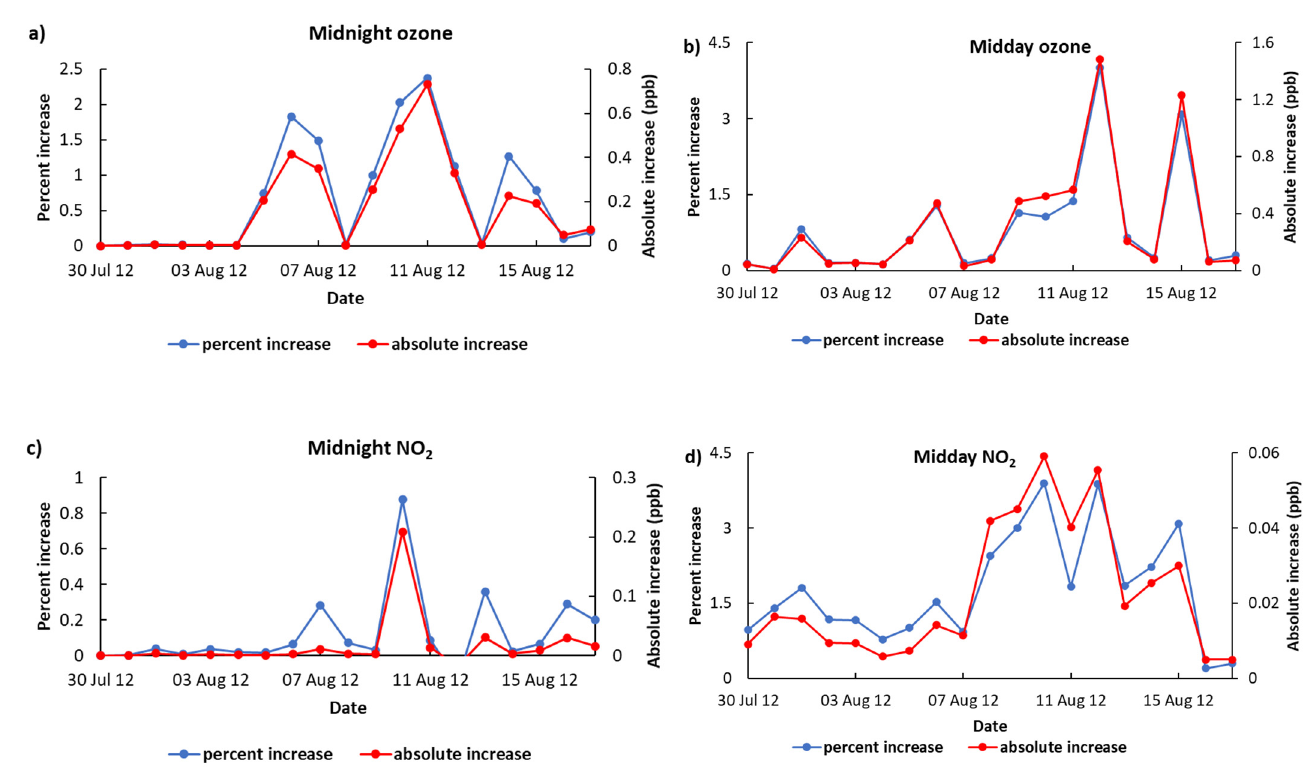
Figure 3. The percent and absolute increase in ozone and NO 2 from WRF-Chem-CRI to WRF-Chem-CRI-WON for ( a ) midnight ozone, ( b ) midday ozone, ( c ) midnight NO 2 , ( d ) midday NO 2 . Note: Absolute increase = (WRF-Chem-CRI–WRF-Chem-CRI-WON) and percent increase = (WRF-Chem-CRI–WRF-Chem-CRI-WON) × 100)/WRF-Chem-CRI-WON.